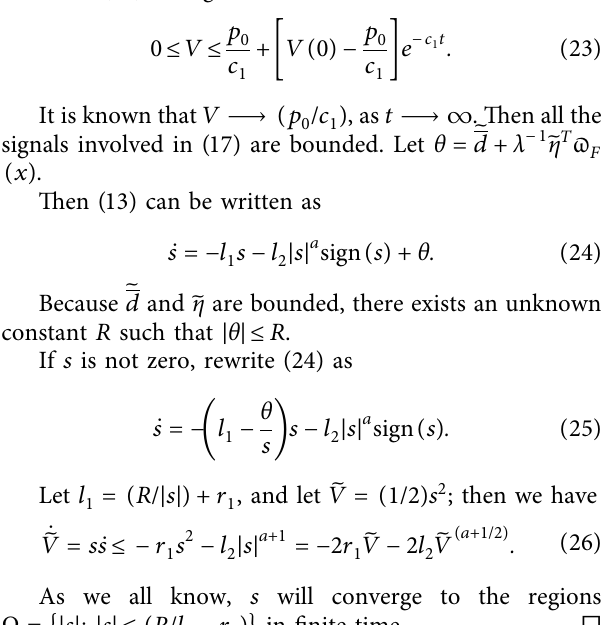
and e by using the method in (27). 1 2